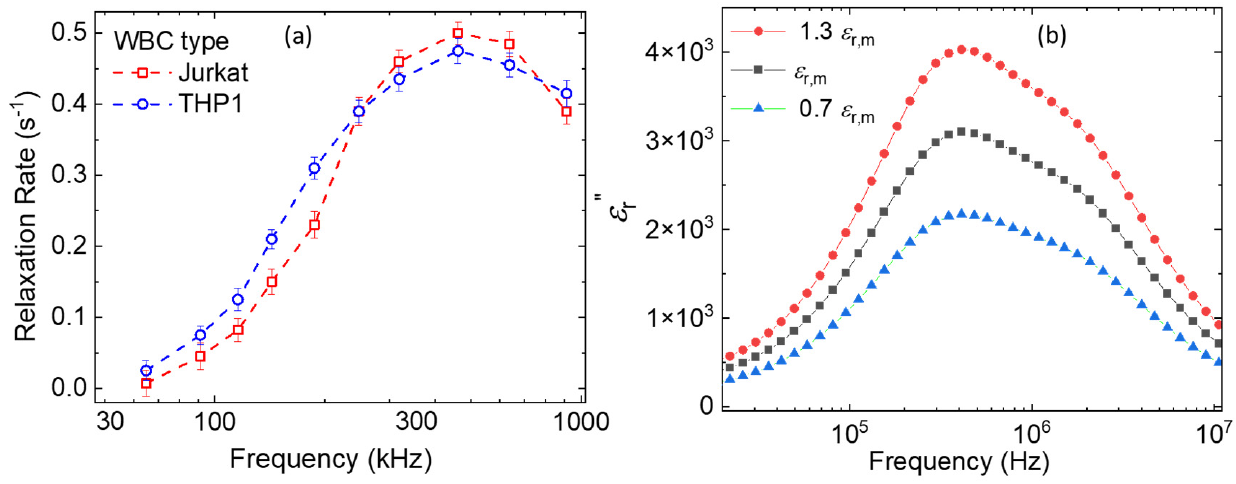
Figure 4. ( a ) The inverse of the time of the “attraction until rest” is recorded at different frequencies and the fixed applied electric field. In the text we elaborate how these data are (1) fit to a polynomial and then (2) extrapolated to obtain the reported crossover frequencies. ( b ) Claussius–Mossotti’s multi-parameter model indicates a possible range of changes of the relative impedance upon addition of Au NPs that allows WBCs to achieve the peak at a similar frequency observed in ( L ). The results in Figure 4 have, in part, informed our motivation to perform the defor- mation study at 700 kHz, which is lower than the MHz range where the relaxation rate and the relative permittivity both start dropping but more than an order of magnitude above the range where the crossover frequencies occur. Additional studies are